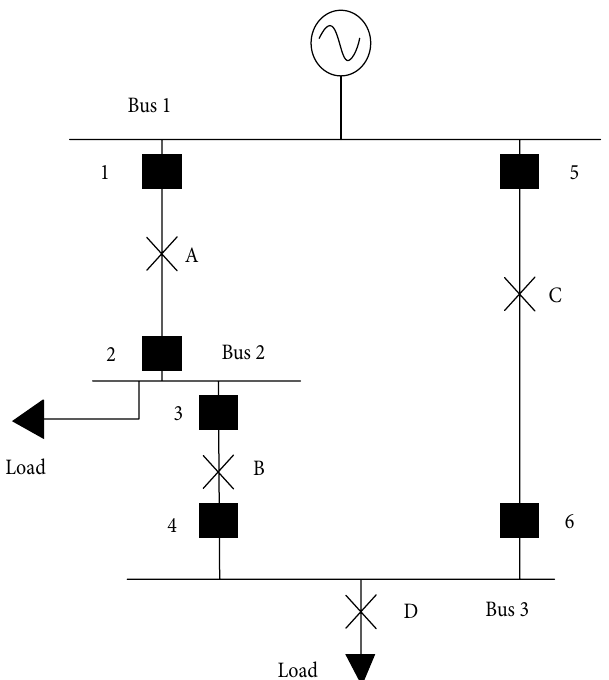
Figure 2: A single end-loop distribution system.